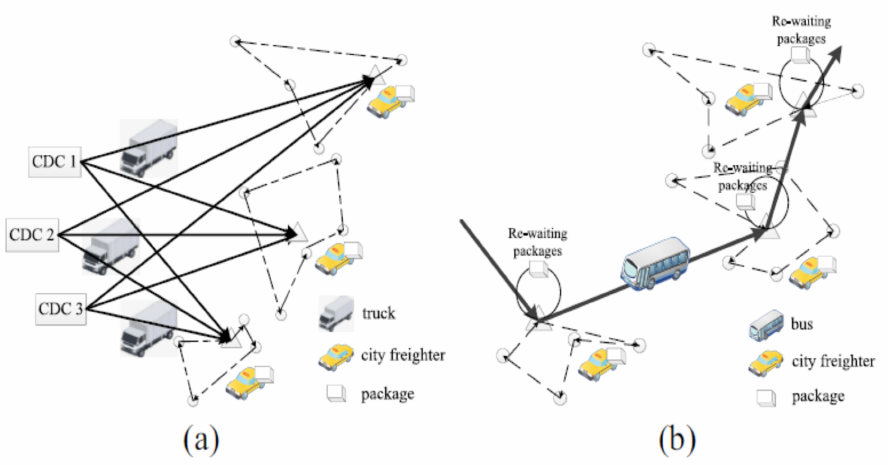
Figure 11. Comparison between traditional logistic distribution ( a ) and CPTS model ( b )